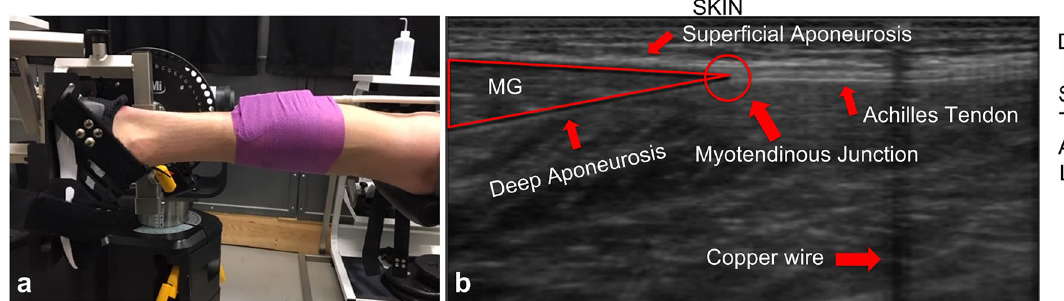
Figure 3. ( a ) Positioning of the participant in the Cybex with the ultrasound probe attached. ( b ) Labelled ultrasound image when probe was secured to the Footwear mechanical testing. Rearfoot cushioning stiffness (compressive stiffness) and energy loss of the footwear was measured using a previously published protocol 5 . Each shoe condition was subjected to three test sessions with each session consisting of 20 consecutive loading and unloading cycles. Each cycle consisted of the shoe being compressed at a rate of 4250 N/s until a maximal load of 1700 N was reached, then the shoe was unloaded. For each shoe, average stiffness and hysteresis values were calculated using the 20th loading–unload- ing cycle from each of the three test sessions and averaged. Data collection. Testing was completed during two sessions. The objective of session one was to measure Achilles tendon moment arm, using a previously published method 36 . Participants laid prone with their knee at 180° (straight leg) and their ankle at 90° in a dynamometer (Cybex NORM, Humac, CA, USA) (Fig. 3). The axis of rotation of the Cybex was aligned with the ankle joint, while the participant’s left foot was secured using Vel- cro straps. Then, participants were fitted with an ultrasound probe (LV8-5N60-A2 transducer, ArtUs EXT-1H, Telemed, Lituania). The ultrasound probe was positioned to measure the movement of the myotendinous junc- tion of the left medial gastrocnemius (Fig. 3). A copper wire was placed on the skin underneath the ultrasound probe. The wire was visible in the ultrasound field of view and was used to determine if the probe moved during the testing session. The probe was placed in a custom 3D printed holder, designed to prevent the probe from rotating off the skin, and was held in place with athletic wrap and gaffer tape. To determine the moment arm of the Achilles tendon, the ankle was passively rotated in the Cybex from 30° to 0° plantarflexion at 5°/s. Three repetitions served as conditioning trials, and on the fourth trial, ultrasound images were recorded. Session two was a treadmill running session and was conducted on an instrumented treadmill (Bertec Corpo- ration, Columbus, USA) set at a 1° incline to mimic outdoor running 37 . The protocol for session two was adapted from previously published methods 4 . The participants were fitted with the ultrasound probe in the same position as session one. The probe was secured by first taping the probe to the skin and then wrapped with athletic wrap. After the ultrasound probe was secured, the test session began with an incremental running test to a submaximal intensity to determine at which speed the participant would reach their anaerobic threshold. A metabolic cart (Cosmed, Rome, Italy) was used to measure breath-by-breath pulmonary gas exchanges. Participants started the test at 2.46 m/s and the speed increased 0.22 m/s every two minutes. The incremental test continued until each athlete reached their anaerobic threshold (via monitoring of the real-time Cosmed output). Anaerobic threshold was visually identified from the real-time data feed by looking for a combination of excessive CO 2 production 38 ,